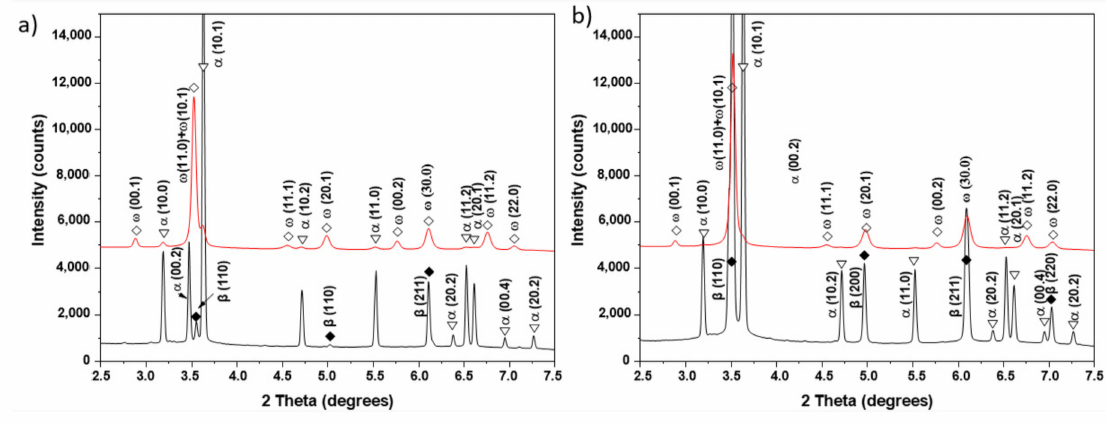
Figure 3. Synchrotron XRD curves of the Ti–3wt.% Nb ( a ) and Ti–20wt.% Nb ( b ) alloys before (black curves) and after HPT (red